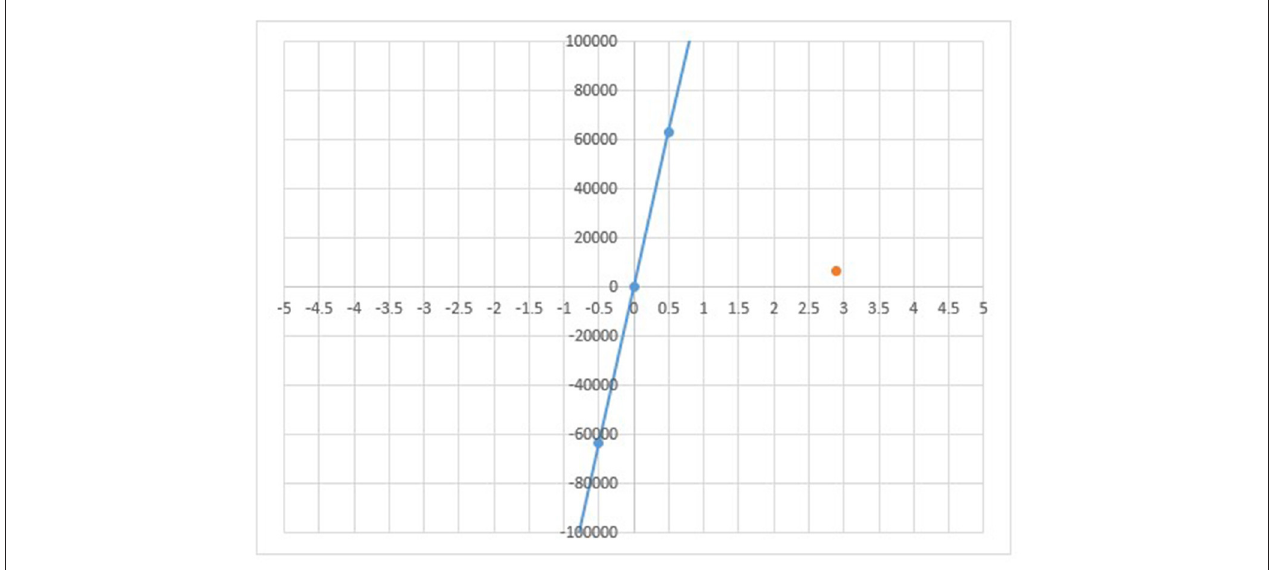
FIGURE 2 | Cost-effectiveness plane in INR. The cost-effectiveness plane depicts ICER (orange dot) lying in the first quadrant because incremental cost of 89.97 USD incurred is saving 2.9 incremental life years. The CER lies below the CE Plane or willingness to pay threshold thus, intervention is cost-effective.